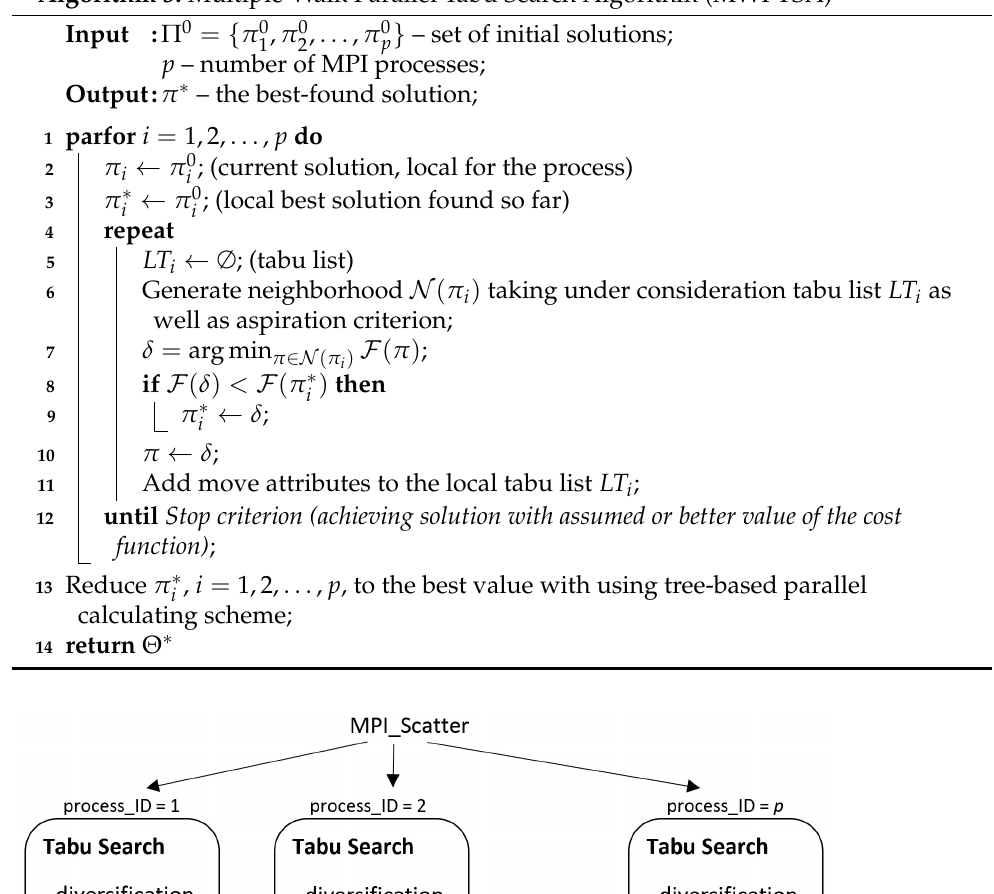
Algorithm 3: Multiple-Walk Parallel Tabu Search Algorithm (MWPTSA)